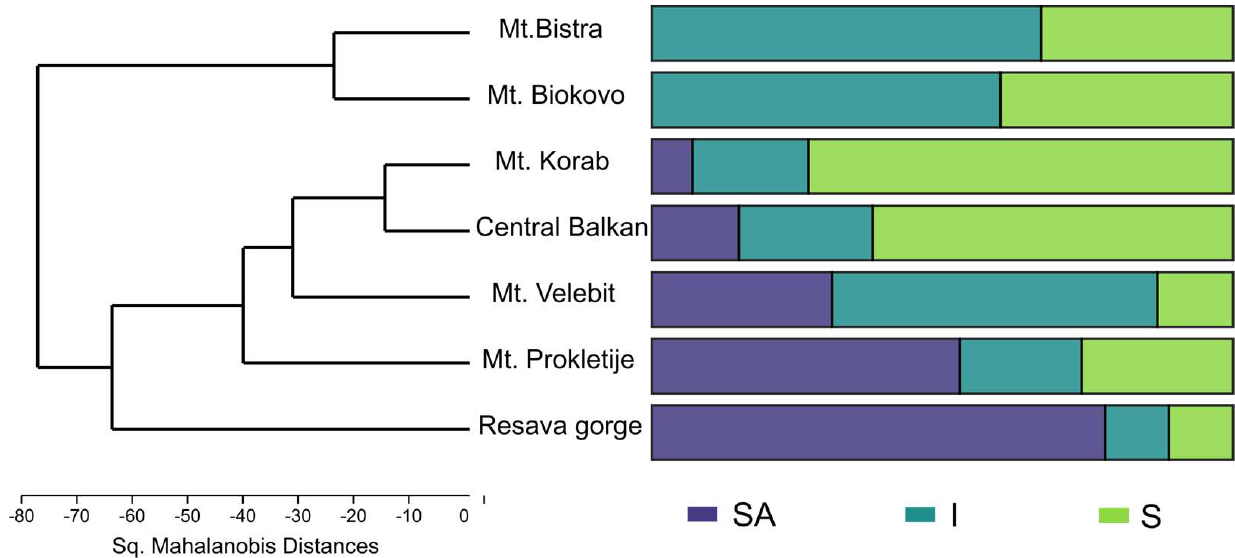
Figure 4. Dendrogram (UPGMA, Sq. Mahalanobis’ Distances); right hand side shows distribution of chemotypes in populations; SA − trans - Sabinyl chemotype; I − Intermediate chemotype; S − Sabinene chemotype.